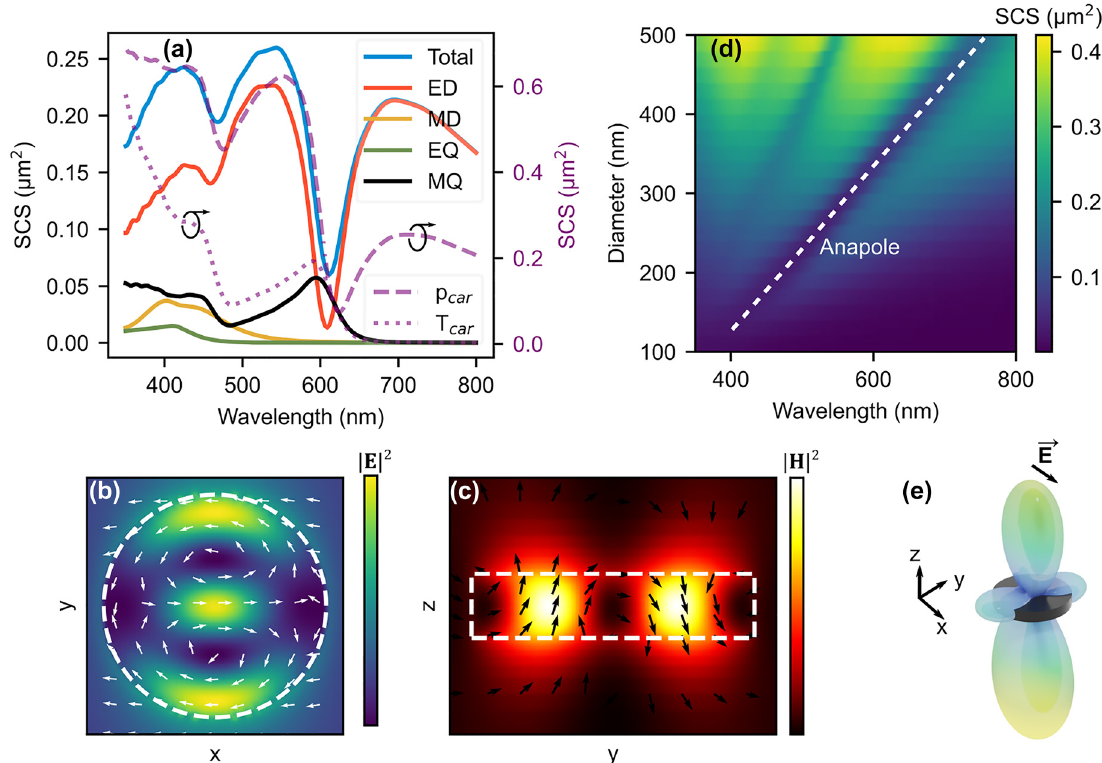
Figure 1: Scattering properties of a single AlGaAs disk in air. (a) Simulated scattering cross section (SCS) of a single AlGaAs nanodisk with diameter of 350 nm and thickness of 50 nm, placed in air (RI = 1). The figure also shows calculated multipole decomposition of the total SCS. ) and dipole ( p ) contributions are shown in the same figure, with scale on the right side. The sharp dip (near The Cartesian toroidal ( T car car 600 nm) in the electric dipole scattering corresponds to the excitation of the first order anapole. (b) | E | 2 at the center height of the disk, wavelength 610 nm. Arrows indicate displacement current direction (not scaled to magnitude) and the white dashed line is the disk border. (c) Magnetic field profile and flux direction. (d) The SCS’s dependence on disk diameter, the anapole state excitation wavelength redshifts with increasing diameter. (e) The far field radiation pattern close to anapole wavelength is dominated by the magnetic quadrupole. The arrow of the electric field indicates the polarization of the incoming